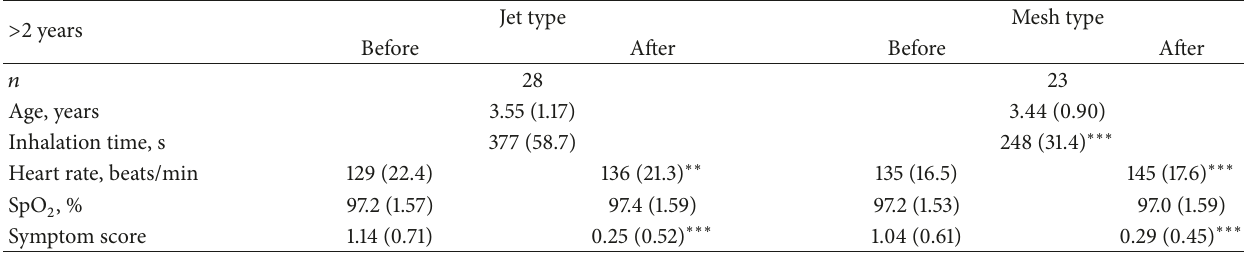
Table 1: Clinical examinations before and after treatment for children ≥ 2 years old.